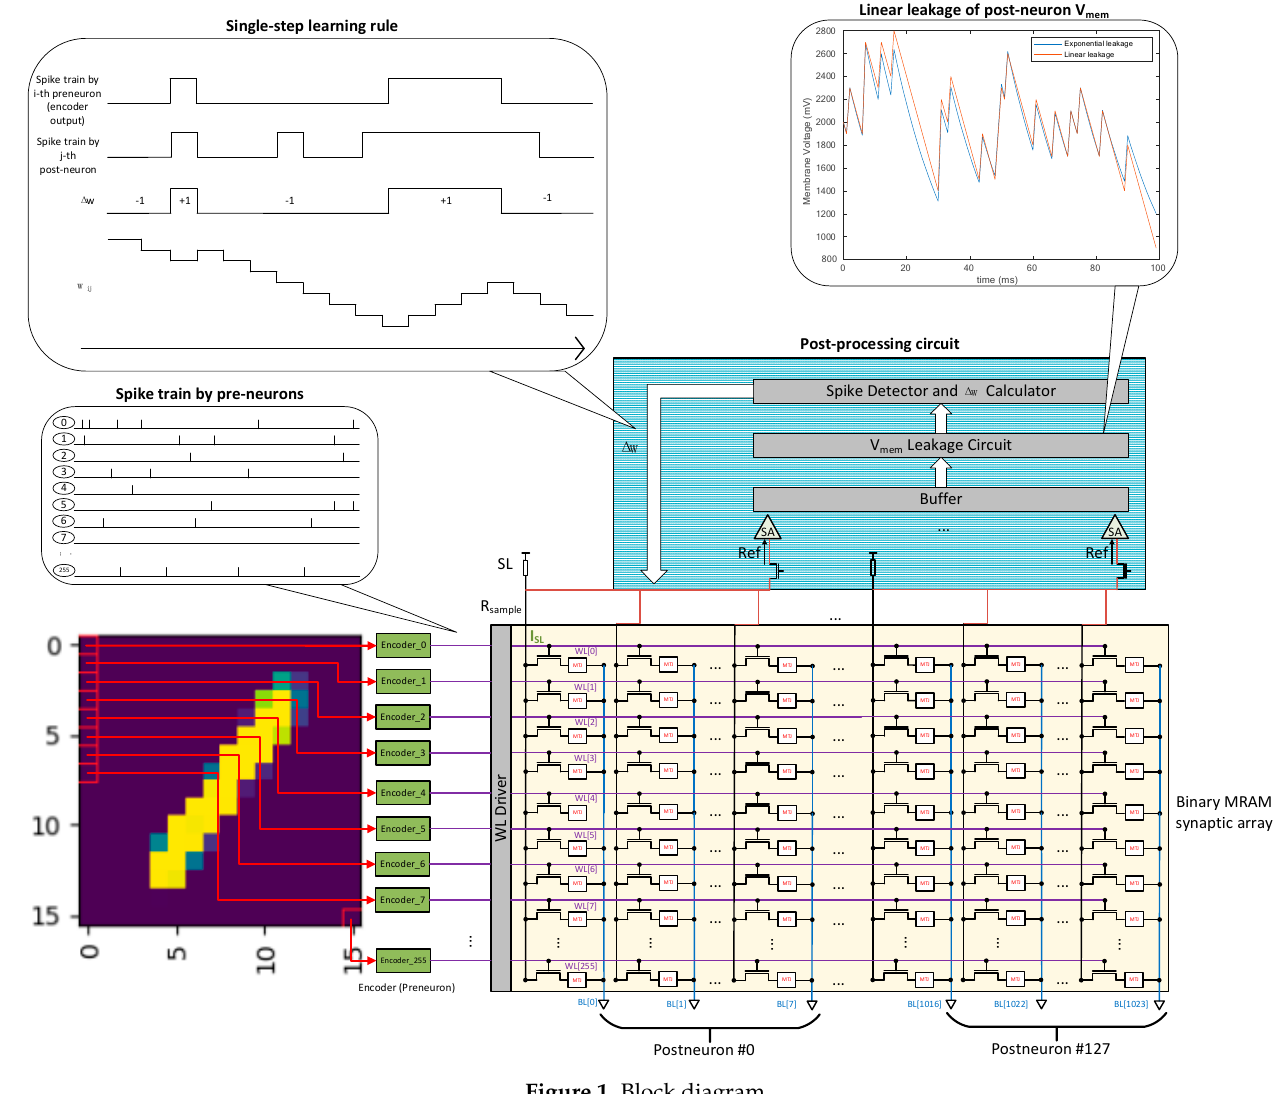
Figure 1. Block diagram.